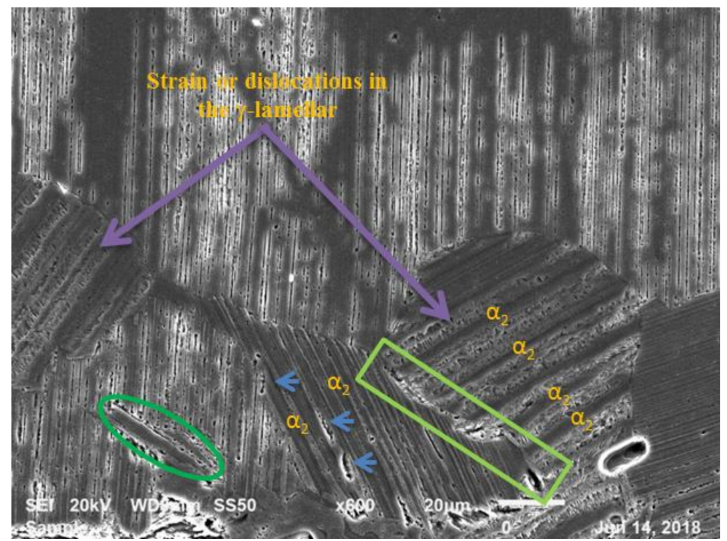
Figure 6. SEM image of the heat-treated sample 3 ( γ phase) at 1430 ◦